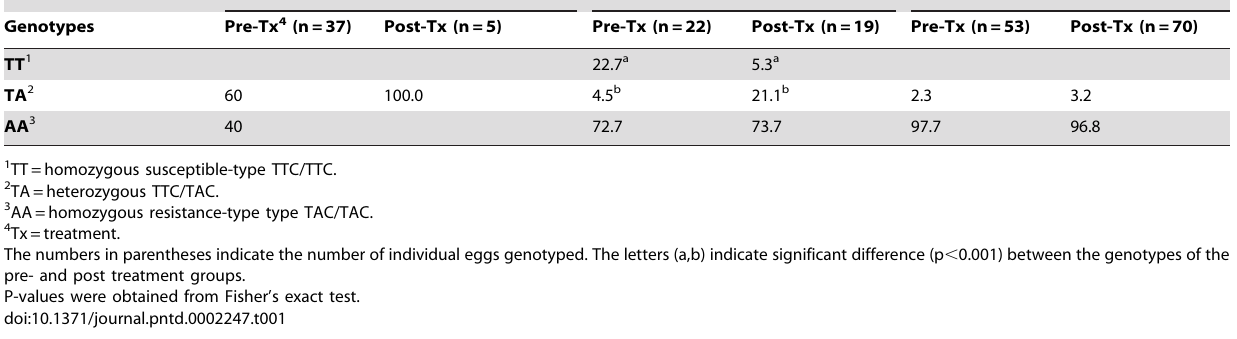
The numbers in parentheses indicate the number of individual eggs genotyped. The letters (a,b) indicate significant difference (p , 0.001) between the genotypes of the pre- and post treatment groups. P-values were obtained from Fisher’s exact test.